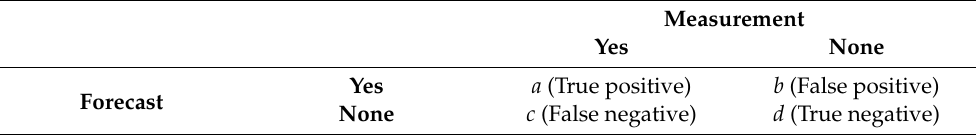
Table 4. Event occurrence